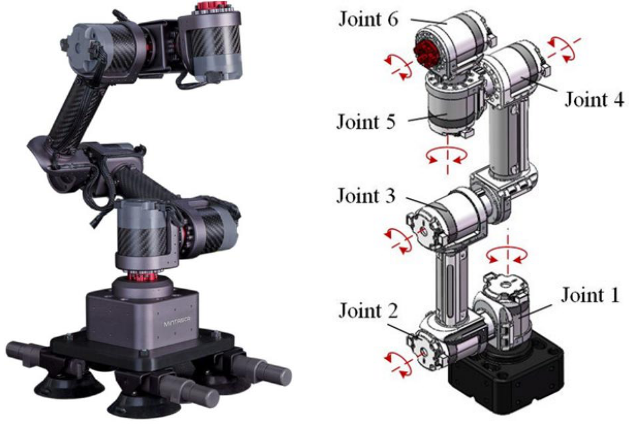
Figure 1. The figure of the real product and the simulation model of the multi-joint robot.